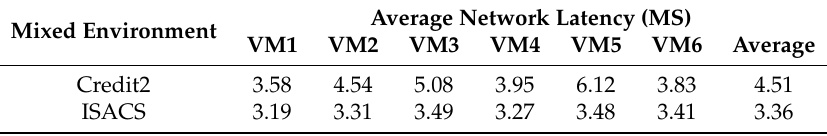
Figure 8. Network latency distribution between 25% and 75% for the results of 2000 experiments with six VMs in a mixed environment. Table 4. Average network latency according to the VM configuration based on Figure